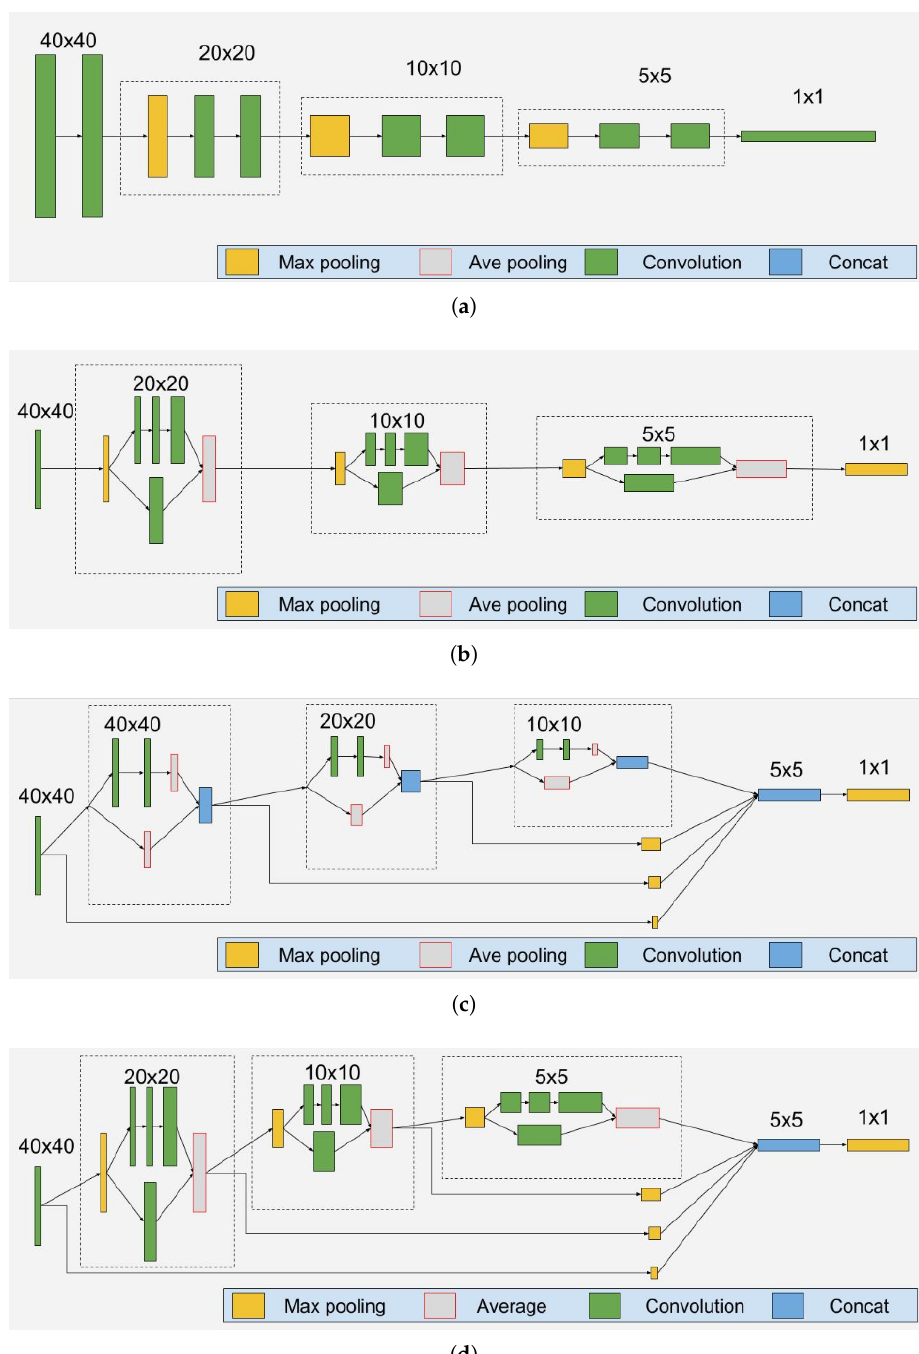
Figure 2. Convolutional network body architectures used for the extraction of spatial information: ( a ) VGGNet, ( b ) ResNet, ( c ) FastMask and ( d ) FastResidualMask. Convolutional layers are coloured green, pooling layers are coloured yellow and the grey are non-parametric layers (i.e.,